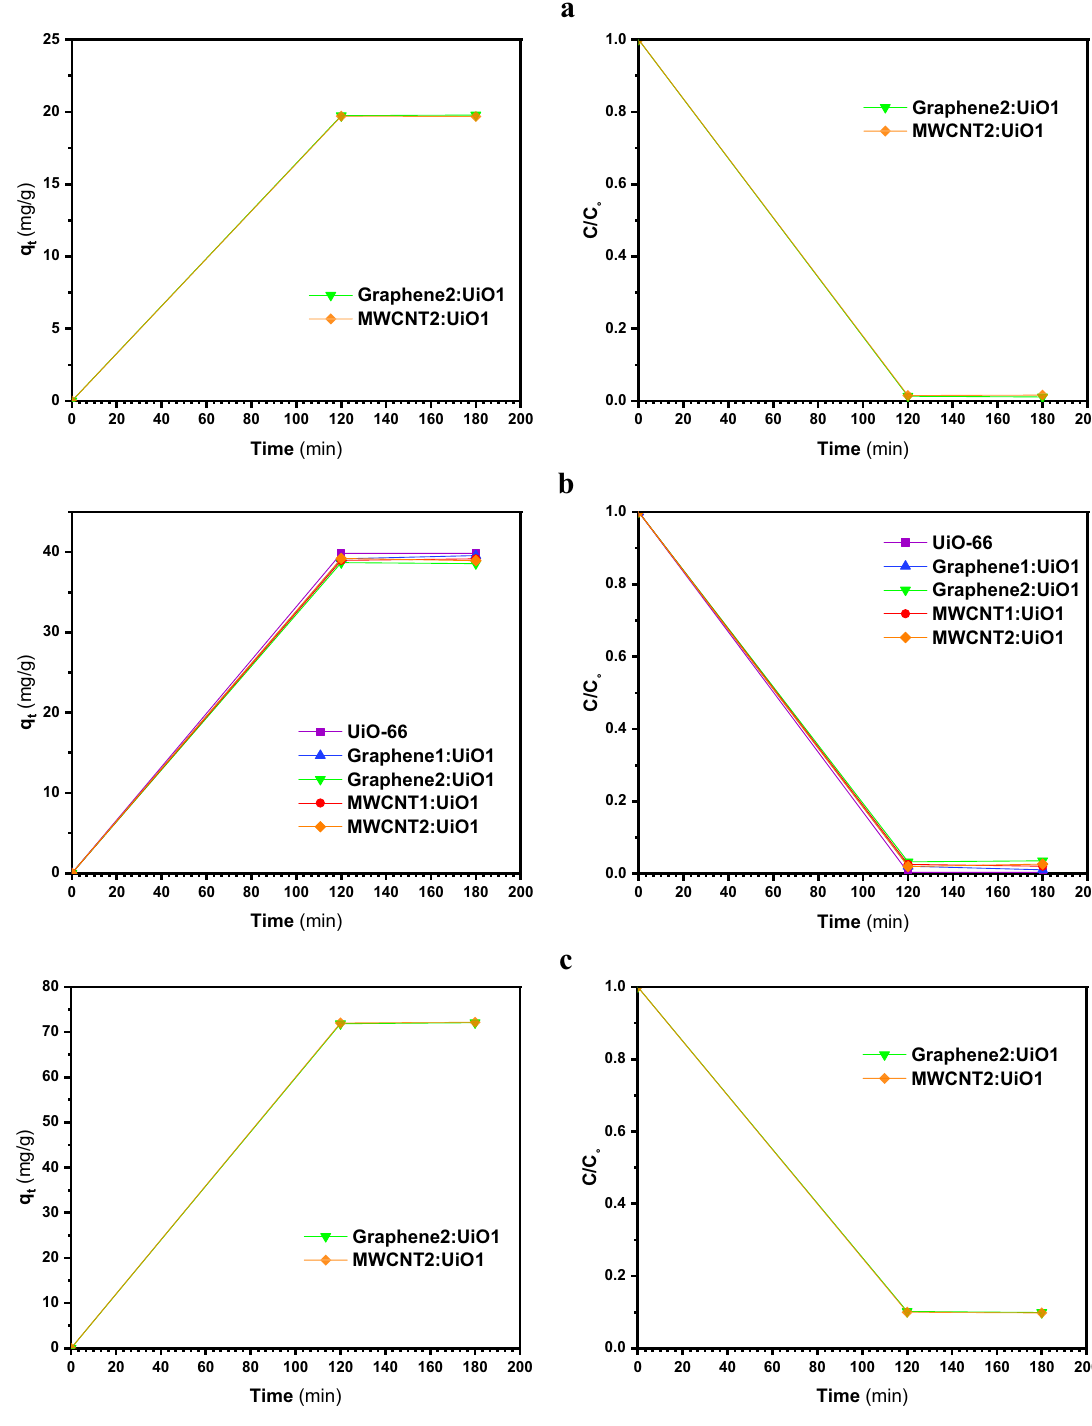
Figure 7. Adsorption capacity and solution concentration versus contact time for different MO initial concentrations of ( a ) 10 ppm, ( b ) 20 ppm, ( c ) 40